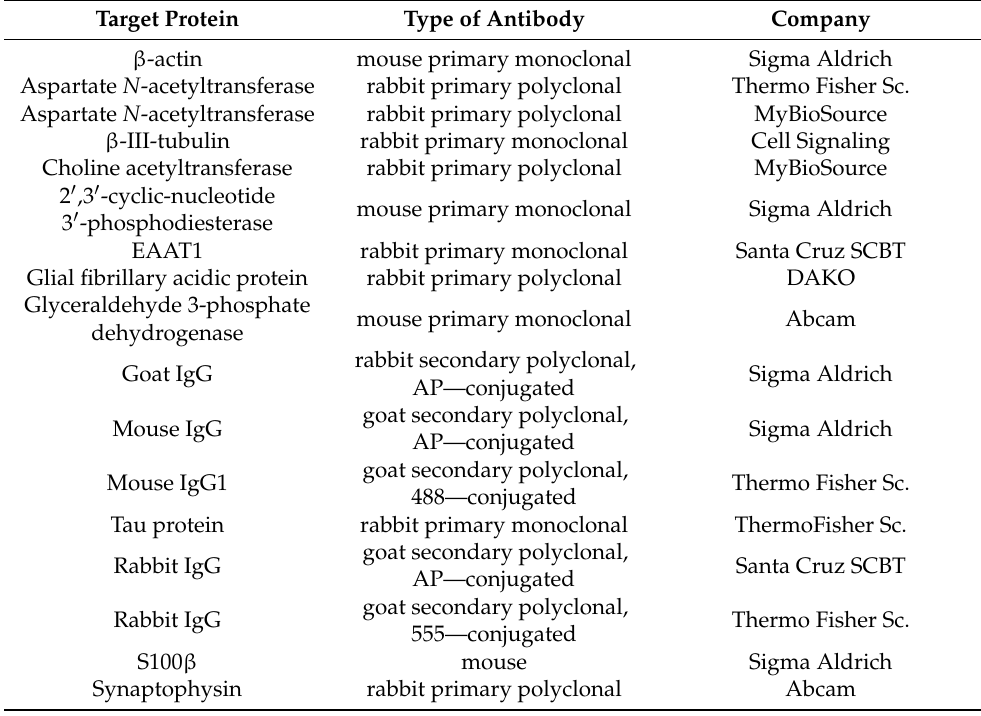
Table 1. A list of antibodies used in this